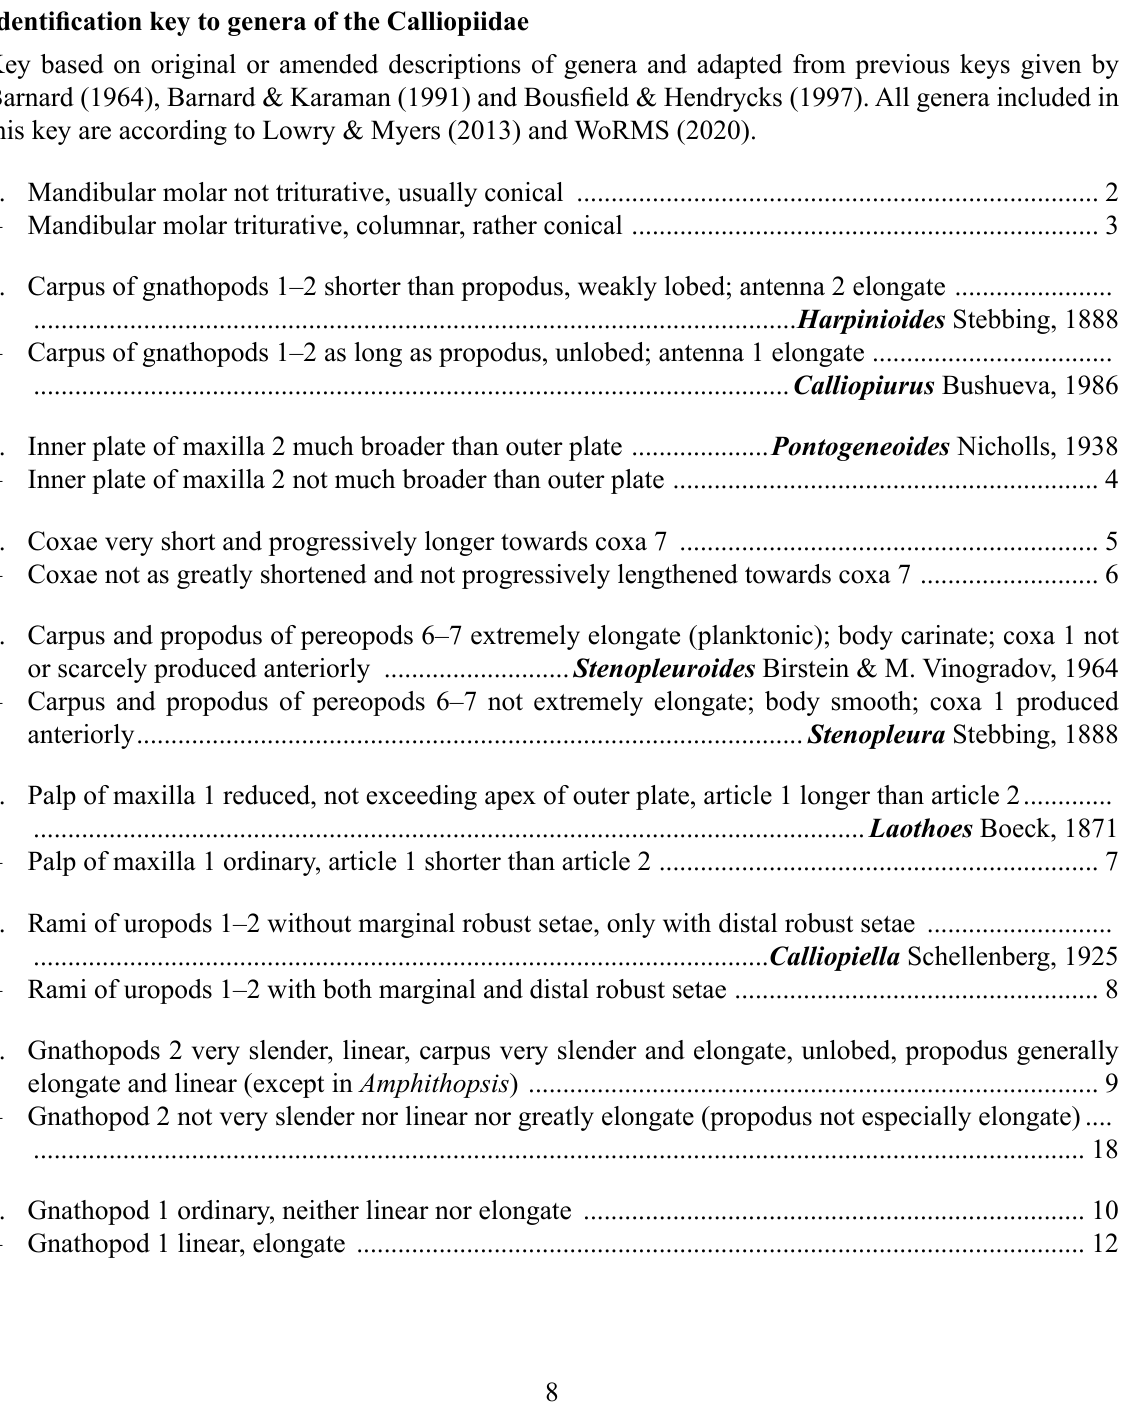
Identification key to genera of the Calliopiidae